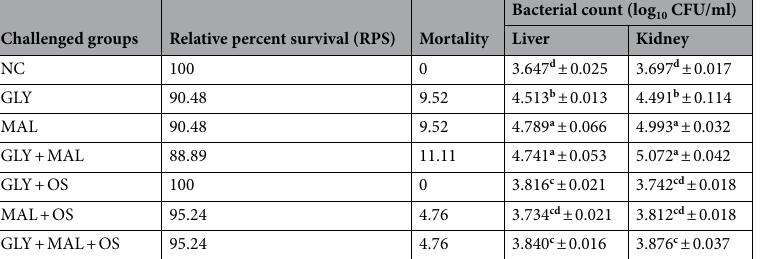
Table 2. Effect of glyphosate and or malathion on fish challenged with Aeromonas hydrophilia and ameliorative effect of organic selenium. Means with different superscripts at the column are statistically different (P < 0.05). NC (negative control); GLY (2 mg L −1 glyphosate); MAL (0.5 mg L −1 malathion); GLY + MAL: (glyphosate 1.6 mg L −1 and malathion 0.3 mg L −1 ). GLY + OS : (glyphosate 2 mg L −1 and Organic Selenium 0.8 g kg −1 diet), MAL + OS : (malathion 0.5 mg L −1 and Organic Selenium 0.8 g kg −1 diet) and GLY + MAL + OS: (glyphosate 1.6 mg L −1 ; malathion 0.3 mg L −1 and OS 0.8 g kg −1